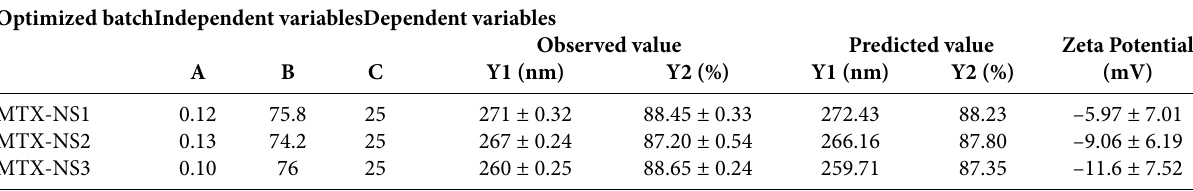
Table 6. Results of optimized batches obtained from an overlay plot of Design expert software Optimized batch Independent variables Dependent